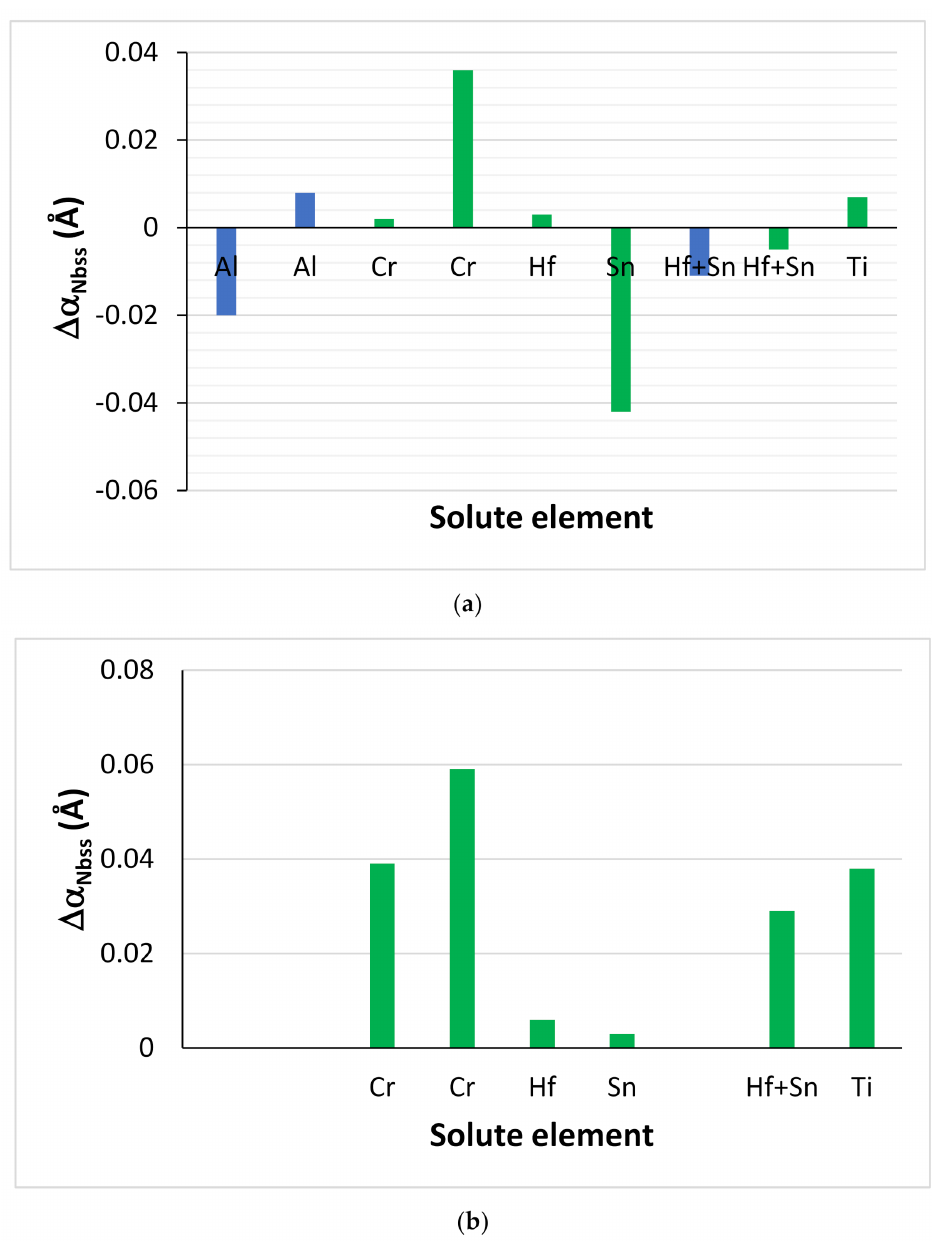
Figure 14. Change of lattice parameter of Nb ss in ( a ) AC and ( b ) HT Nb-18Si-based RM(Nb)ICs. Note that Ti was present in all alloys with the exception of the alloy EZ1. For nominal alloy compositions and the lattice parameter data, see the Table 5. Green color is used for the ∆ α Nbss of alloys for which there is data for the AC and HT conditions. In ( a ), from left to right, alloy comparisons are as follows: KZ3-AC vs. KZ7-AC (i.e., ∆ α Nbss = α KZ3 − α KZ7 ), EZ2-AC vs. EZ5-AC, KZ3-AC vs. KZ4-AC, EZ2-AC vs. EZ6-AC, NV6-AC vs. EZ2-AC, KZ3-AC vs. NV6-AC, KZ7-AC vs. EZ5-AC synergy with Al, KZ4-AC vs. EZ6-AC synergy with Cr, and EZ1-AC vs. EZ2-AC. In ( b ), from left to right, alloy comparisons are as follows: KZ3-HT vs. KZ4-HT, EZ2-HT vs. EZ6-HT, NV6-HT vs. EZ2-HT, KZ3-HT vs. NV6-HT, KZ4-HT vs. EZ6-HT synergy with Cr, and EZ1-HT vs.